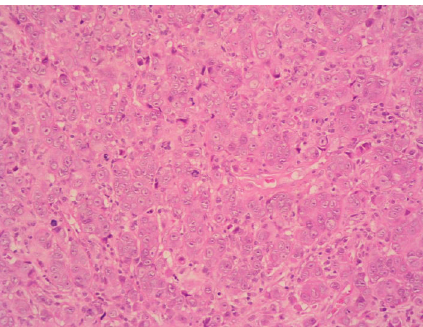
Figure 1: Hematoxylin and eosin stained section of cerebellar lesion at 20x magnification showing general cytoarchitectural features of the tumour.